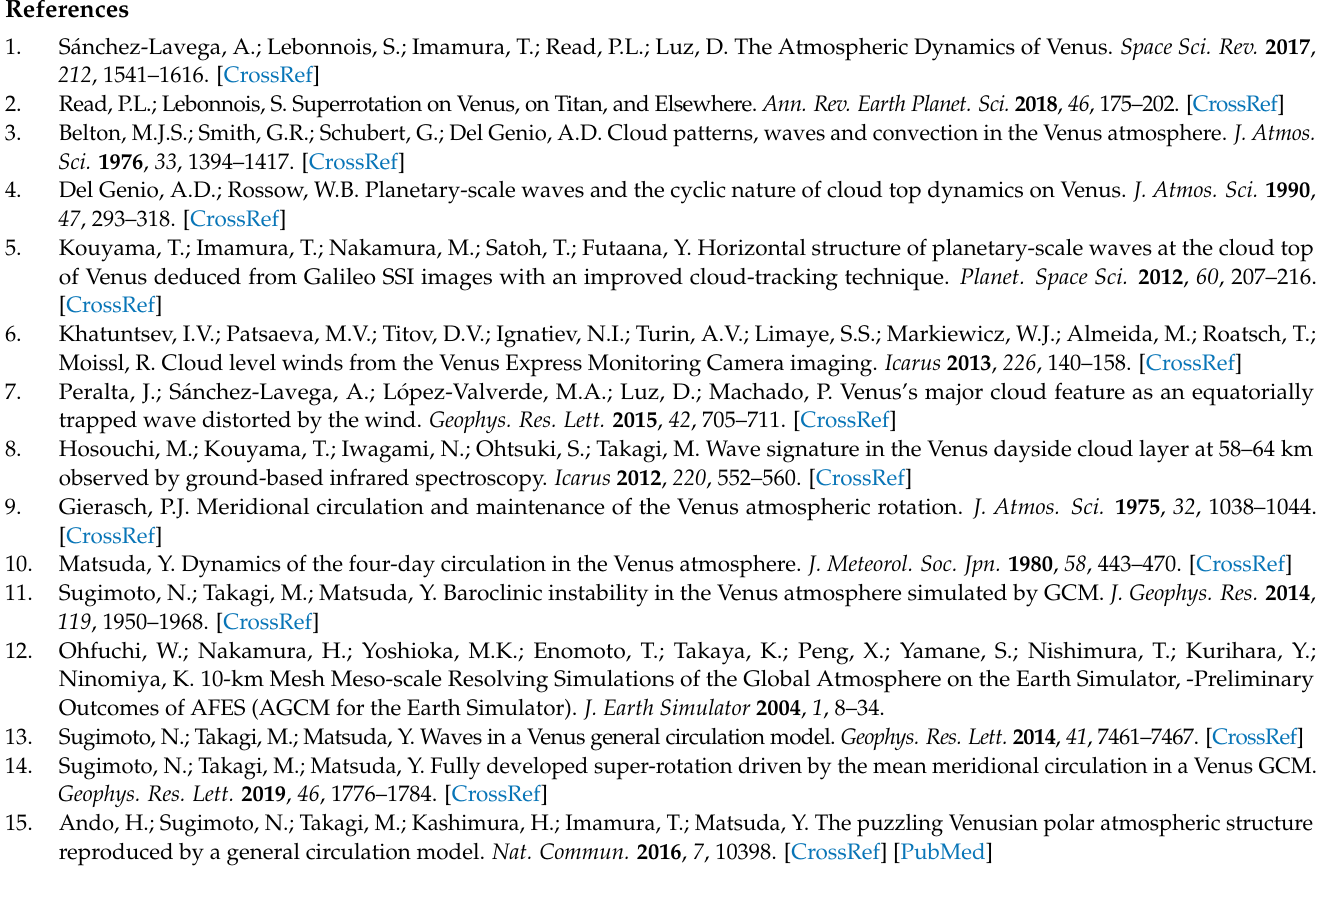
Figure A2. Ensemble spreads (SPRD) of zonal (solid lines) and meridional (dotted lines) winds averaged at 70 km calculated by Equation (A1) from 1 January 2005. ( a ) Latitudinal dependency in case of assimilating data at the same time interval of 6 h. ( b ) Observation frequencial dependency in case of assimilating data at the same latitudinal range of 15 ◦ S–15 ◦ N. The ensemble spreads of Frf (free run forecast) are also shown in each